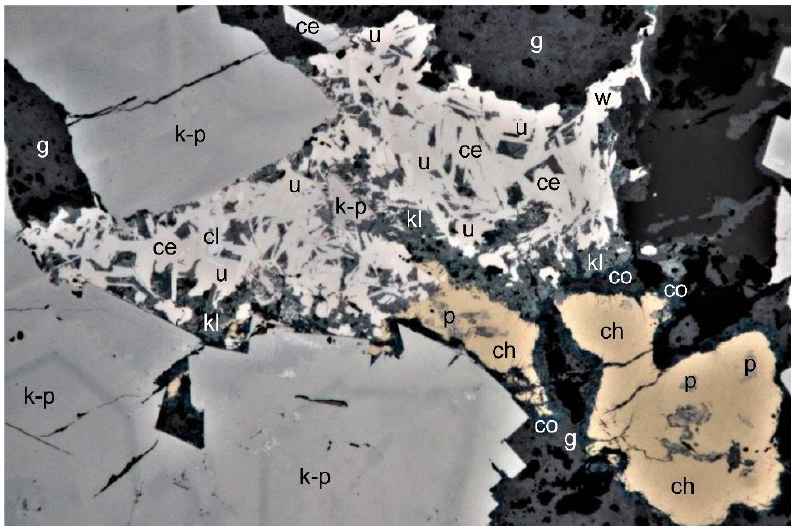
Figure 5. Type-II cerromojonite-bearing pseudomorph progressively altered by goethite and sulfides (reflected light, horizontal field of view is 500 µ m). Abbreviations: ce = cerromojonite, ch = chalcopyrite, cl = clausthalite, co = covellite, g = goethite, kl = klockmannite, k–p = krut’aite–penroseite solid solution, p = penroseite, w = watkinsonite, u = unnamed CuNi 2 Se 4 .